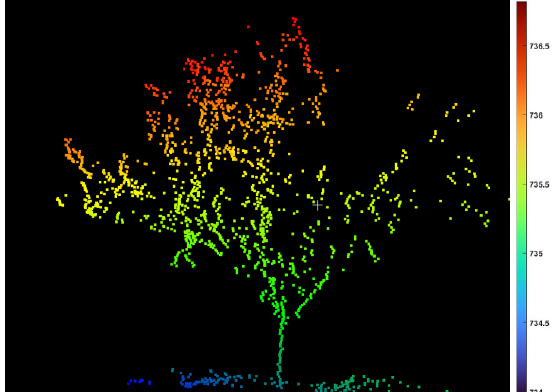
Figure 13. Visualization of a representative peach tree 3D data captured using the 3D LiDAR system. The color scale refers to height (z) data in m above sea level.